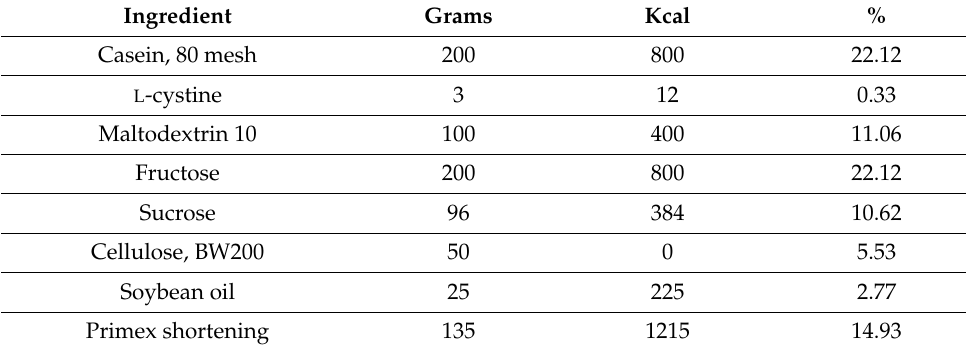
Table 2. Ingredients of the used Western-style